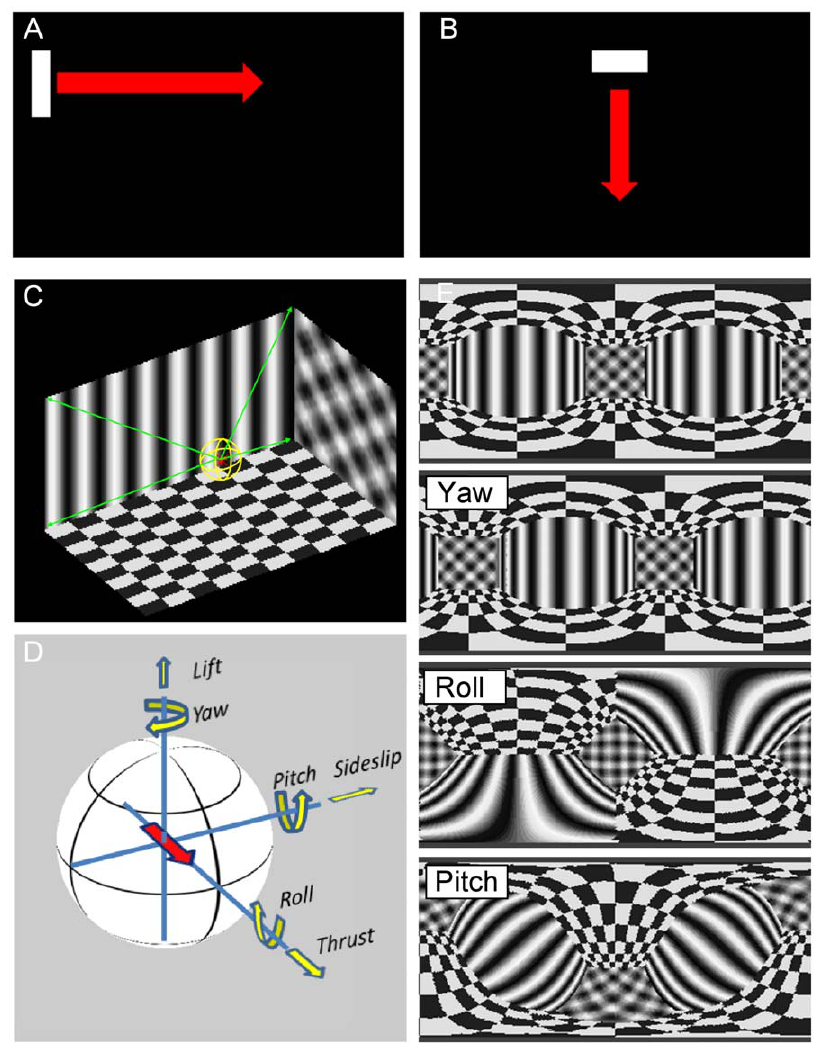
Figure 4. Visual stimuli used to stimulate the lobula plate network. a,b To probe the receptive field, a small bar is moved first horizontally to the right at several elevations (a) and subsequently vertically down at several azimuth positions (b). c Virtual environment to create full-field ego- motion stimuli. The walls of the virtual room are projected onto a sphere. d The sphere can be rotated and translated according to the 6 degrees of freedom. e Example snapshots shown in spherical coordinates from image movies obtained for three different kinds of rotations.